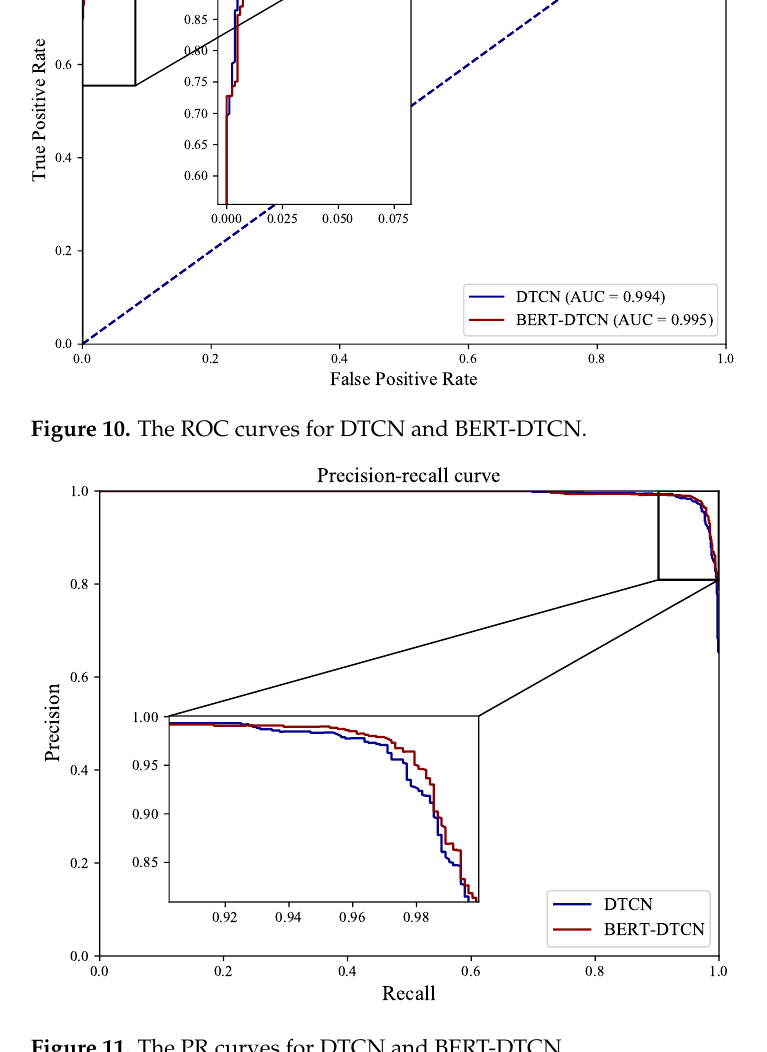
Figure 11. The PR curves for DTCN and